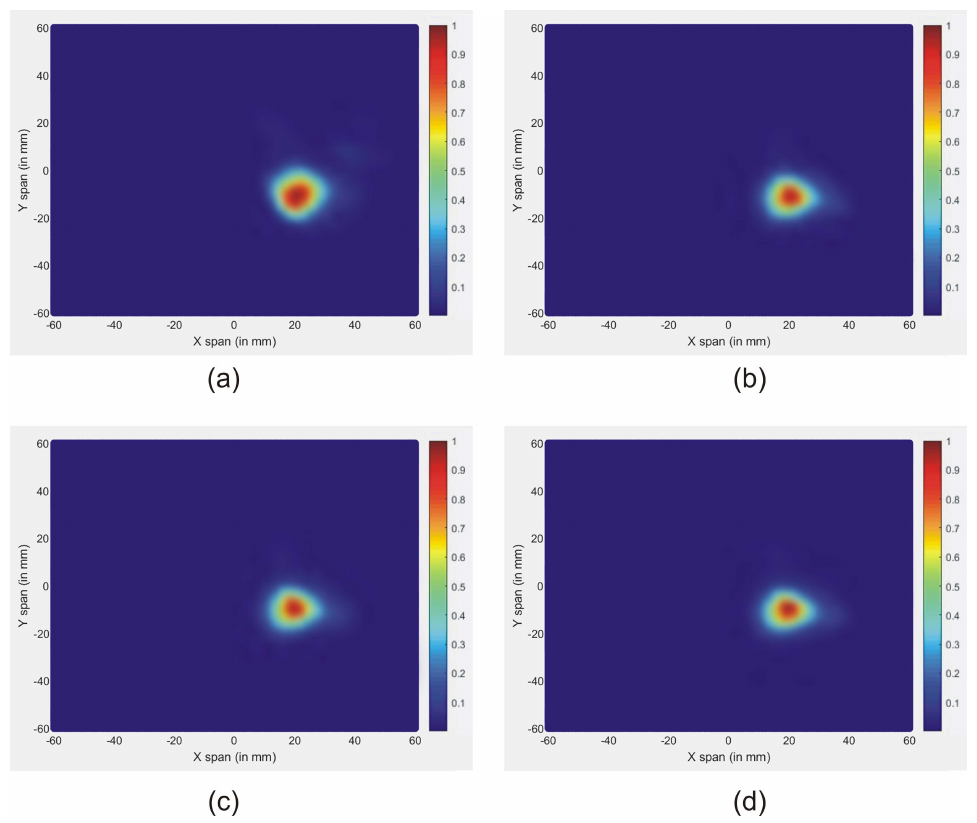
Figure 9. Reconstructed images of different tumor permittivity: ( a ) Tumor 1, ( b ) Tumor 2, ( c ) Tumor 3, and ( d ) Tumor